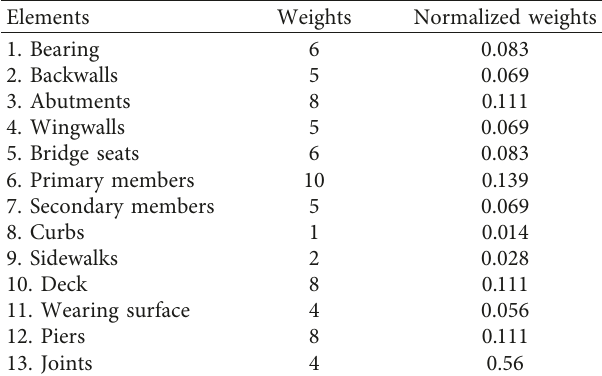
Table 2: Bridge elements and weights used in New York